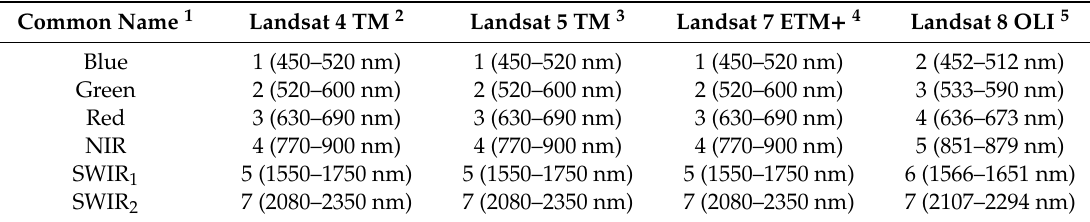
Table A1. Harmonization of the specific band numbers to common spectral names.